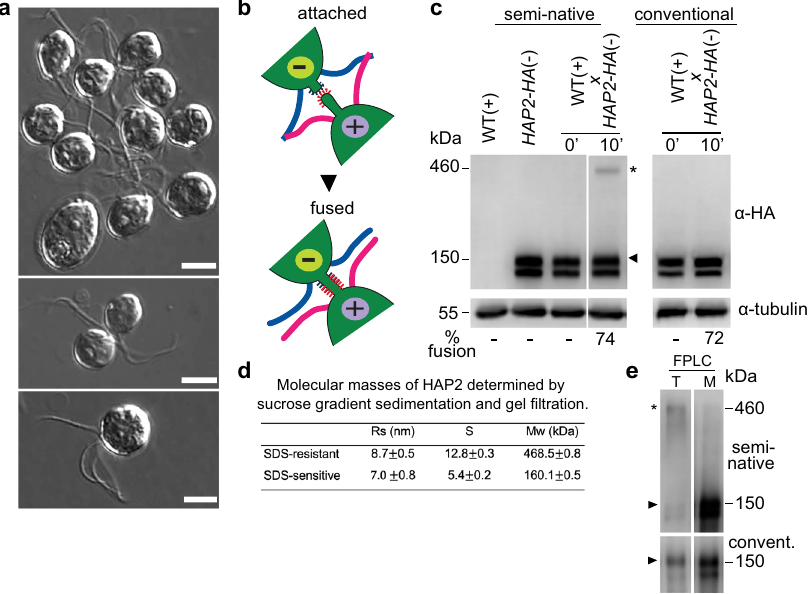
Fig. 1 During gamete fusion, HAP2 rearranges into a trimer. a Differential interference (DIC) microscopic images of p lus and minus gametes that been mixed together for ~5 min followed by gentle addition with minimal agitation of an equal volume of 5% glutaraldehyde. Clusters of gametes adhering by their cilia (upper panel). A pair of gametes interacting at their apical ends during mating structure adhesion and fusion (middle panel). A quadri-ciliated zygote (lower panel). Scale bars, 5 μ m. This experiment was repeated 5 times. b Illustration of mating structure adhesion and fusion. c Upon gamete fusion, an SDS-resistant HAP2 trimer appears that is stable to semi-native SDS-PAGE conditions. HAP2-HA minus gametes were mixed with WT plus gametes for 10 min and subjected to conventional SDS-PAGE (right panel) or semi-native SDS-PAGE (left panel) followed by immunoblotting with an anti-HA antibody. In the 0-min samples, the cells were suspended in sample buffer and then mixed. The percentage of gametes that fused to form quadri-ciliated cells is indicated below the blots. At least 200 cells were counted. The trimer band is indicated by an asterisk and the monomer band is indicated by an arrowhead. d Determination of HAP2 molecular mass by use of sucrose gradient separation and gel fi ltration of immunopuri fi ed fh1-HAP2-HA (see below for information about the fh1 mutant). Results are means of 3 independent biological replicates whose peak fraction positions were used to calculate the monomer and oligomer sedimentation coef fi cients and Stokes radii. e Semi-native (upper panel) and conventional (lower panel) SDS-PAGE analyses of peak trimer (T) and monomer (M) gel fi ltration fractions of immunopuri fi ed fh1-HAP2-HA. The experiment was repeated 3 times with similar